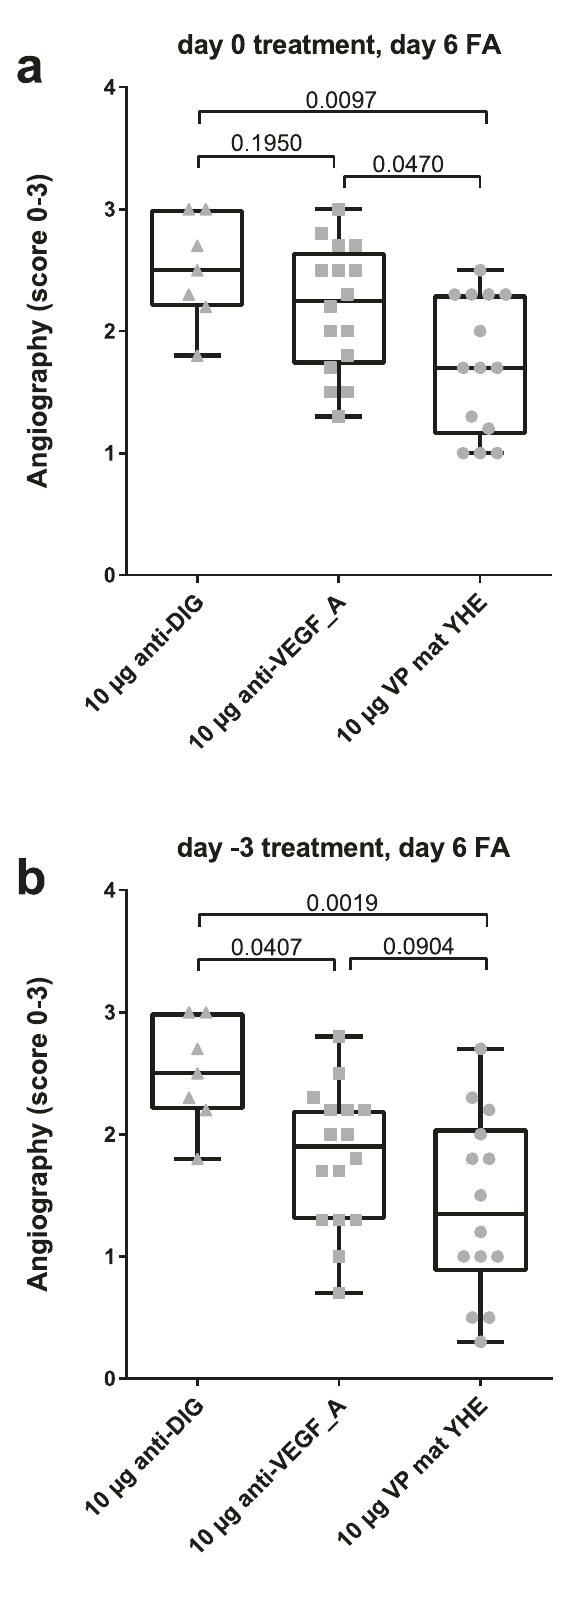
species after 4 weeks at 4 °C at high concentration, and only a minor increase in aggregates when incubated for 4 weeks at 40 °C, indicating suitability for the development of high-concentration liquid formulations. Moreover, a late aggregation onset tem- perature of approximately 70 °C for DutaFab VP mat YHE was determined by static light scattering (Fig. 7c).